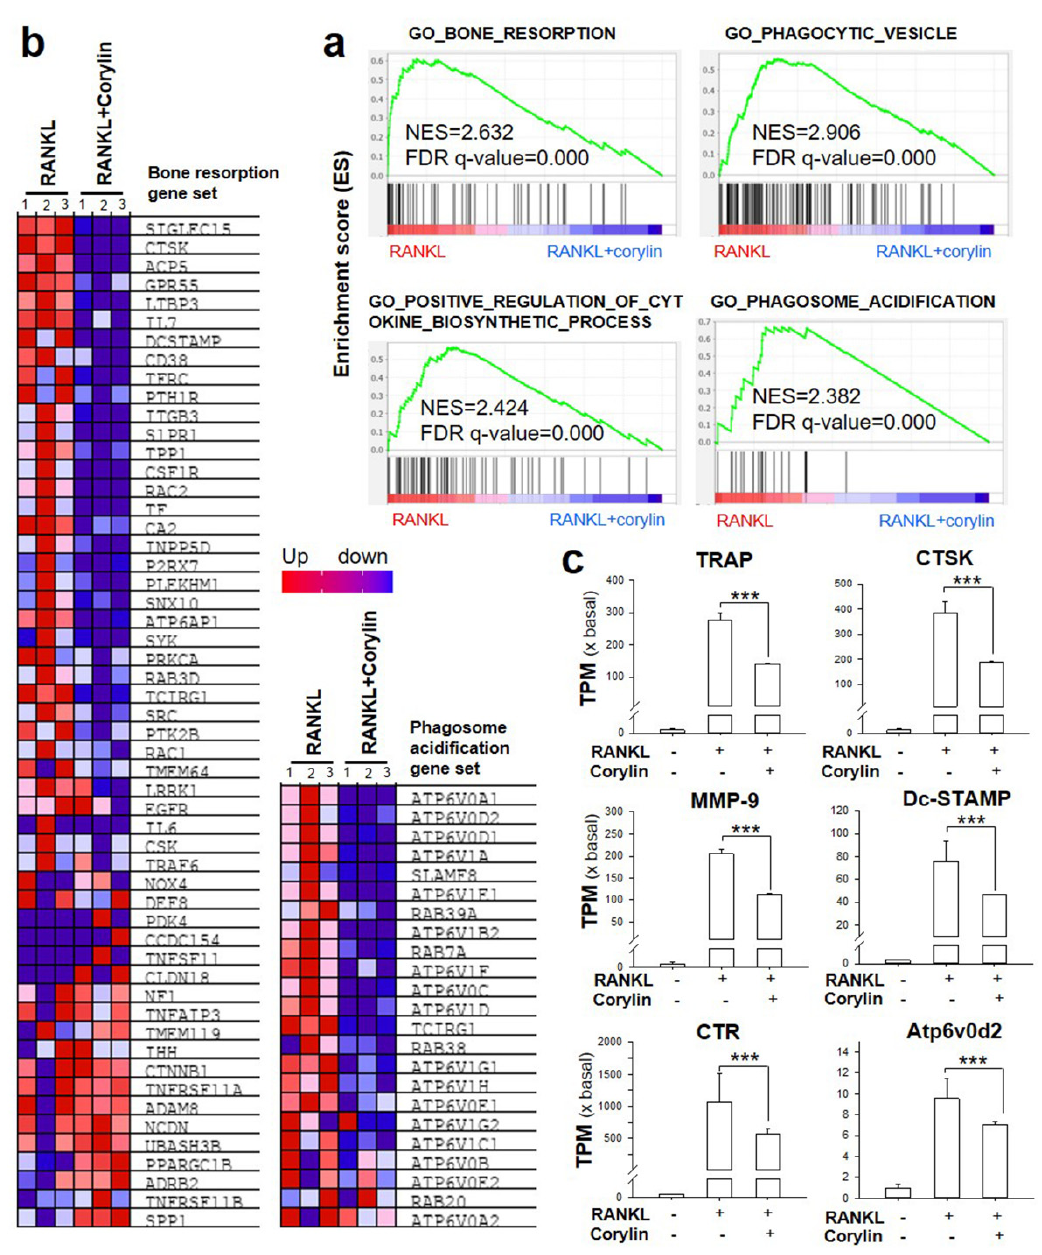
Figure 5. The gene set de-enriched by corylin in transcriptomics. ( a ) Transcriptomics were done from cultures, as in Figure 4. GSEA enrichment plots using the gene ontology (GO) gene set enriched “bone resorption” (NES = 2.632, FDR q-value < 0.000), “phagocytic vesicle” (NES = 2.906, FDR q-value < 0.000), “phagosome acidification” (NES = 2.382, FDR q-value < 0.000), and “positive regulation of cytokine biosynthetic process” (NES = 2.424, FDR q-value < 0.000). Enrichment plots revealed the profile of the running ES score and positions of gene set members on the rank ordered list. ( b ) Heat map of the top features for each phenotype in gene expression GSEA collapsed to gene symbols, representing clustering of mRNA expression levels in cells treated with RANKL or RANKL in the presence of corylin for 4 days. Each column represents the indicated sample; each row indicates one gene. Expression values are represented as colors, where the range of colors (red, pink, light blue, dark blue) shows the range of expression values (high, moderate, low, lowest, respectively). ( c ) The expression levels of osteoclast markers (TRAP, cathepsin K (CTSK), CTR, dendritic cell-specific transmembrane protein (DC-STAMP), MMP − 9, and Atp6v0d2) in bone marrow macrophages treated with 5 μ M corylin + RANKL for 4 days. The value is expressed as fold to control (x basal; vehicle), in mean ± SD, n = 3. *** p < 0.001, compared with RANKL-treated control. TPM: transcripts per kilobase million.